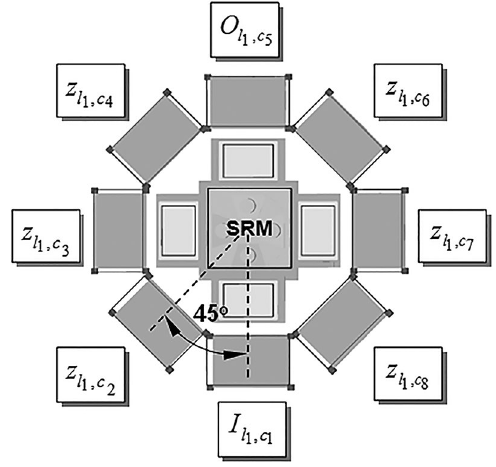
Fig. 3. C-AS/RS operation environment